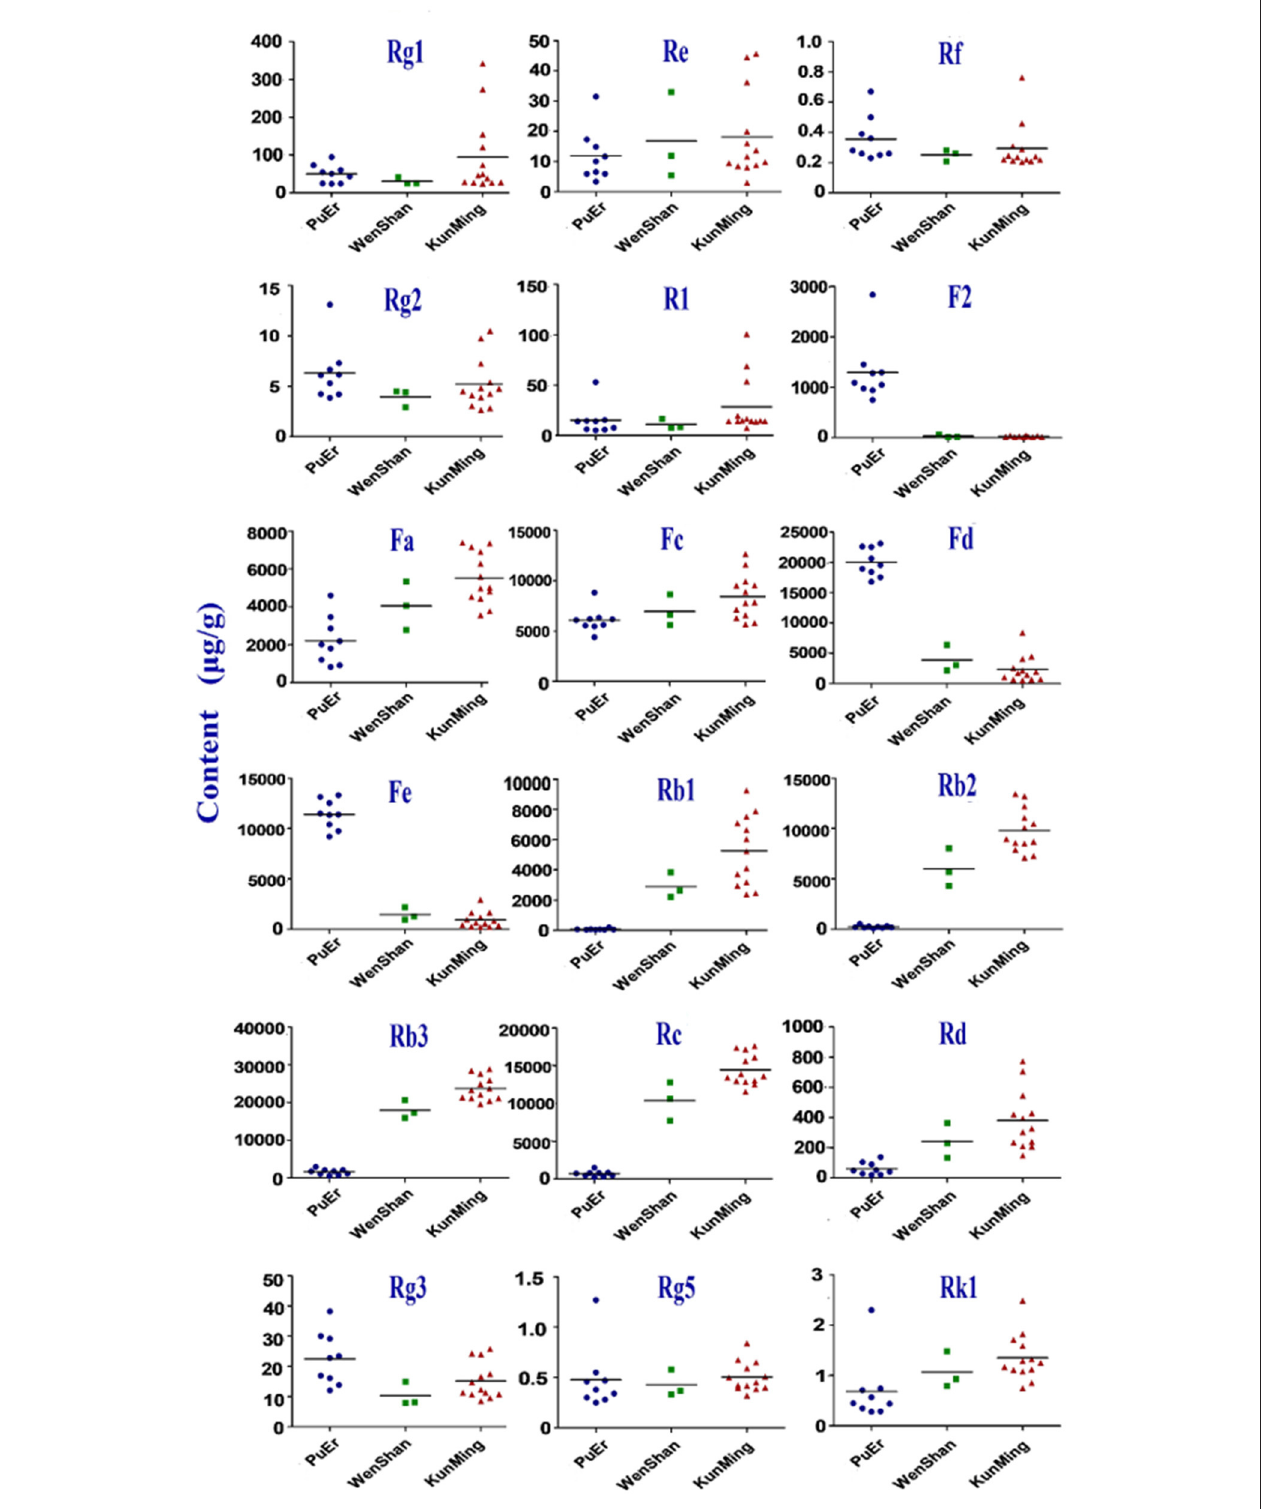
FIGURE 3 | Contents of 18 saponins in leaf of P. notoginseng from different origins.